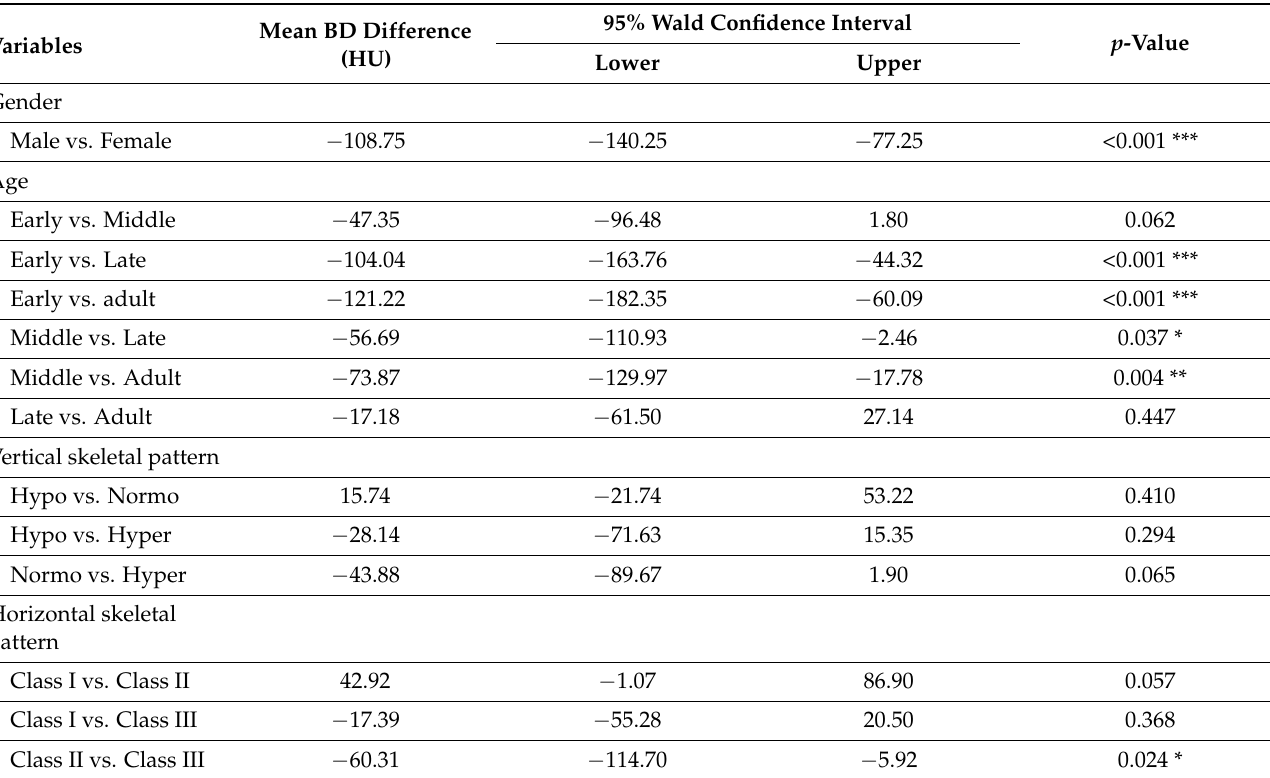
Table 4. A generalized linear model is derived from comparing midpalatal bone densities (BDs) according to gender, age, and skeletal